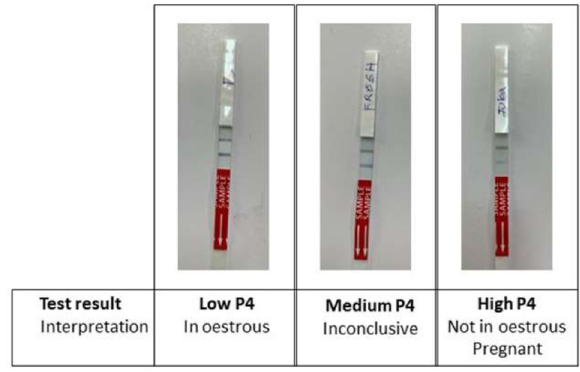
Figure 2. Ridgeway P4 Rapid test results and interpretation. The lower line is the test line (in response to progesterone) and the upper line is the reference/control line (indicates that the test has run correctly). Low P4 is indicated by a stronger test line; medium P4 is indicated by equal lines; high P4 is indicated by a weaker test